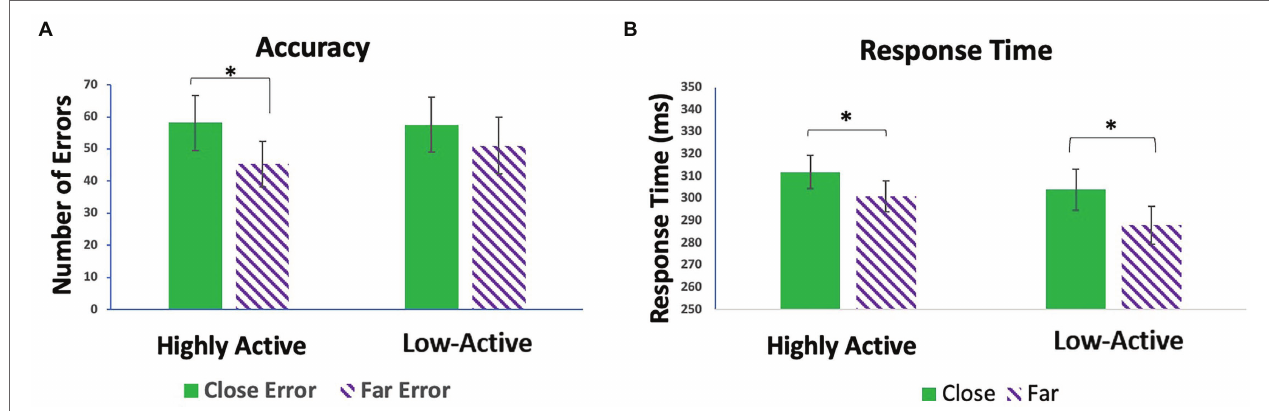
FIGURE 2 | (A) Mean number of errors made on close vs. far trials in the highly active (HA) and low-active groups. (B) Mean response times on close vs. far trials in the HA and low-active groups. Error bars reflect SE; * denotes p <